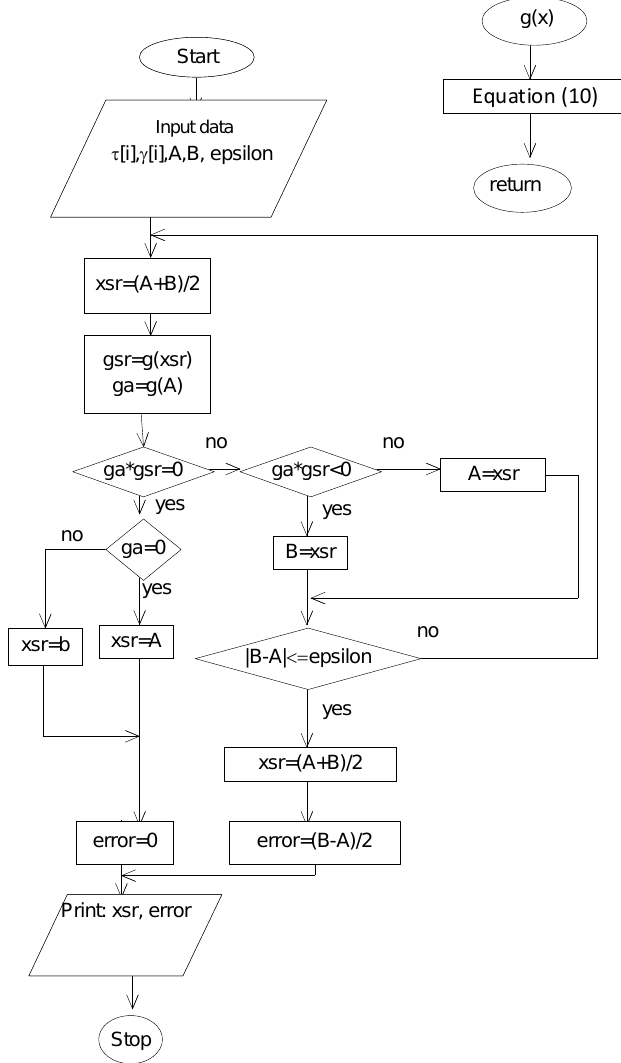
Figure 1. Flow chart for the calculation of the root of the g ( x ) function being in the range (A,B) by means of the bisection method.